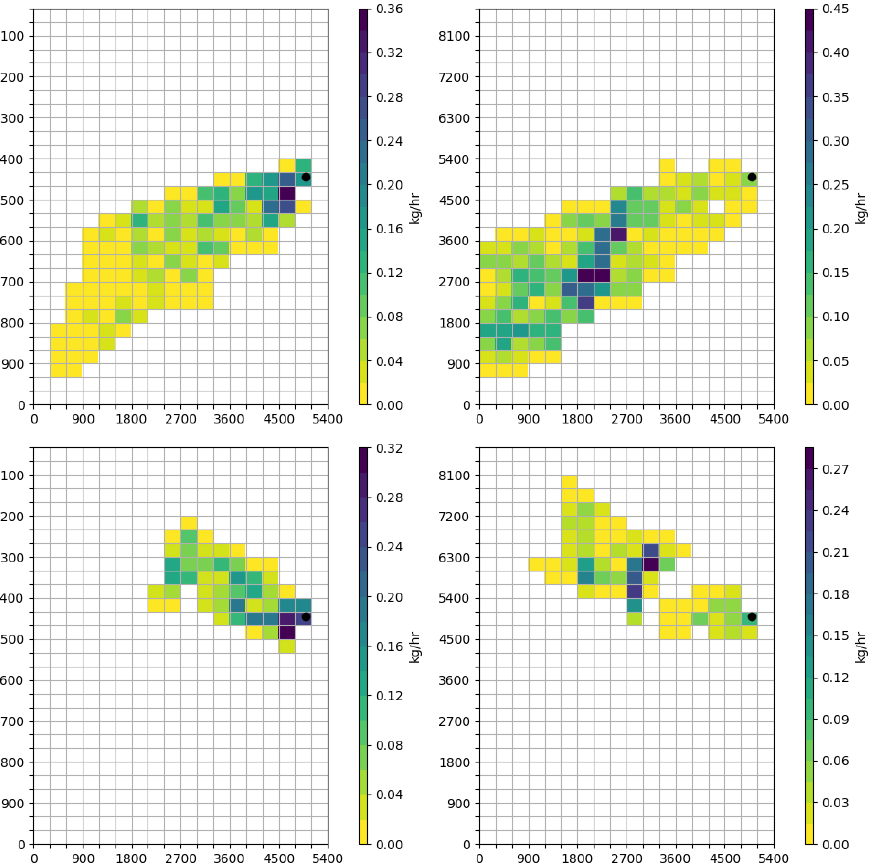
Figure 5. The area source map is shown for all four cases described in Table 2. In the left column the map for the first point (“Edgar tower”) for wind regime of 2 m/s in 240 direction (first row) and 3 m/s in 300 direction (second row). In the right column, the corresponding maps for the second POI (“Ben-Gurion junction”) is shown for both meteorological scenarios. In all cases the POI is located at (5000,5000) (shown by a black